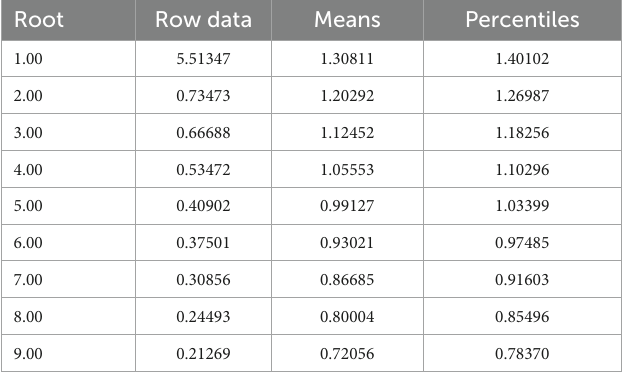
TABLE 3 List of RSO parallel test eigenvalues and eigenfactors. Root Row data